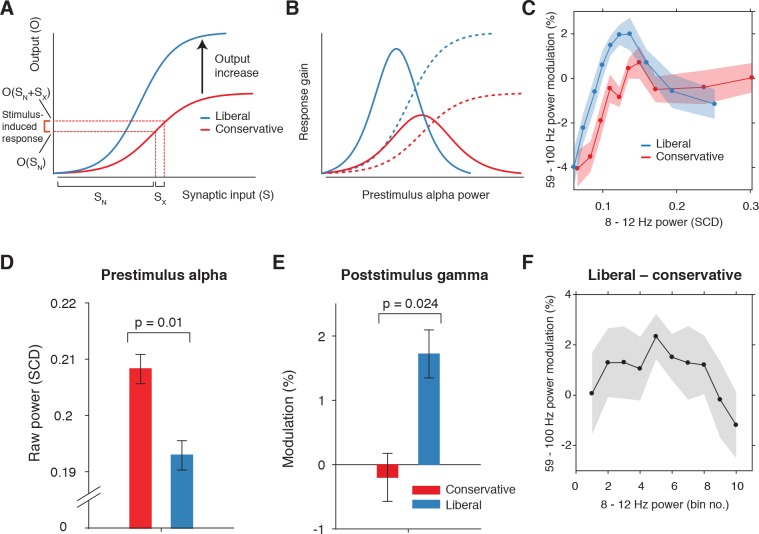
Pre-stimulus alpha power is linked to cortical gamma responses.(A) Theoretical response gain model describing the transformation of stimulus-induced and endogenous input activity (denoted by Sx and SN respectively) to the total output activity (denoted by O(Sx +SN)) in visual cortex by a sigmoidal function. Different operational alpha ranges are associated with input-output functions with different slopes due to corresponding changes in the total output. (B) Alpha-linked output responses (solid lines) are formalized as the first derivative (slope) of the sigmoidal functions (dotted lines), resulting in inverted-U (Gaussian) shaped relationships between alpha and gamma, involving stronger response gain in the liberal than in the conservative condition. (C) Corresponding empirical data showing gamma modulation (same percent signal change units as in Figure 3) as a function of alpha bin. The location on the x-axis of each alpha bin was taken as the median alpha of the trials assigned to each bin and averaged across subjects. (D-F) Model prediction tests. (D) Raw pre-stimulus alpha power for both conditions, averaged across subjects. (E) Post-stimulus gamma power modulation for both conditions averaged across the two middle alpha bins (5 and 6) in panel C. (F) Liberal – conservative difference between the response gain curves shown in panel C, centered on alpha bin. Error bars, within-subject SEM across participants (N = 14).10.7554/eLife.37321.014Figure 6—source data 1.SPSS .sav file containing the data used in panels C, E, and F.